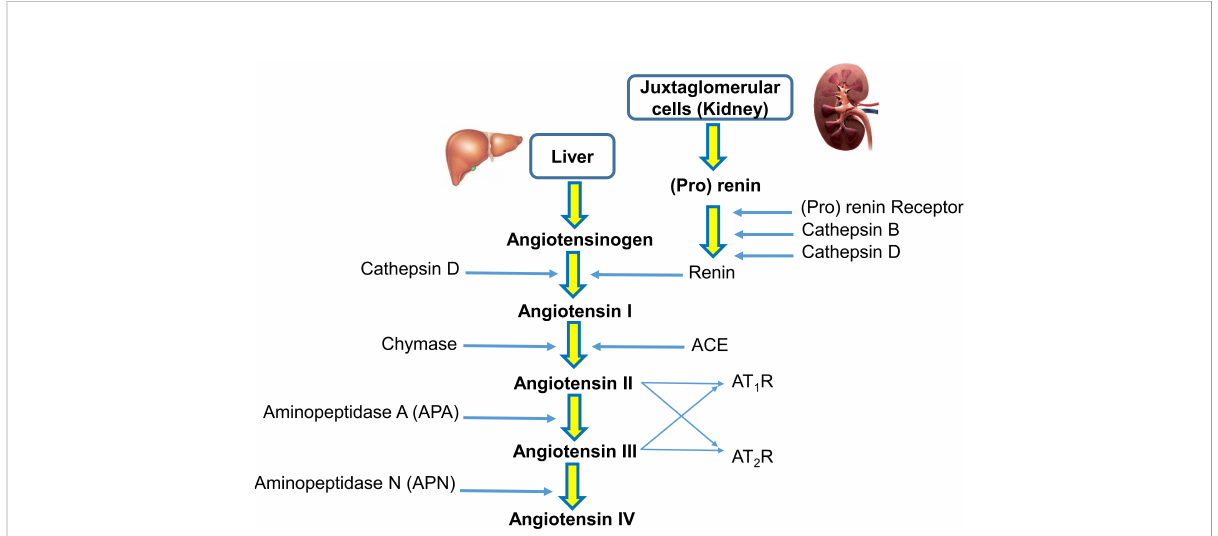
FIGURE 1 A simpli fi ed view of the renin-angiotensin system (RAS). In the RAS, (pro)renin activation is caused by its binding to the (pro)renin receptor. Cathepsins B and D are also renin-activating enzymes. Renin and cathepsin D converts angiotensinogen to angiotensin I, which is acted upon by angiotensin-converting enzyme (ACE) and chymase to produce angiotensin II. Aminopeptidase A (APA) converts angiotensin II to angiotensin III. Angiotensin II and angiotensin III act on the AT1R receptor and AT2R receptor. Aminopeptidase N (APN) converts angiotensin III to angiotensin